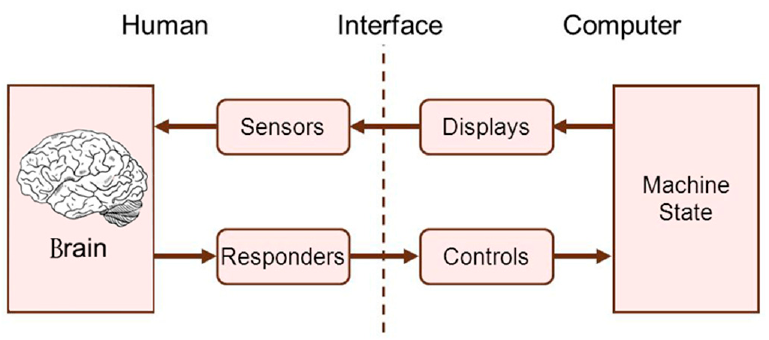
Figure 2. The human-factor view of the human operator in a working environment [22]. Figure 2. The human‑factor view of the human operator in a working environment